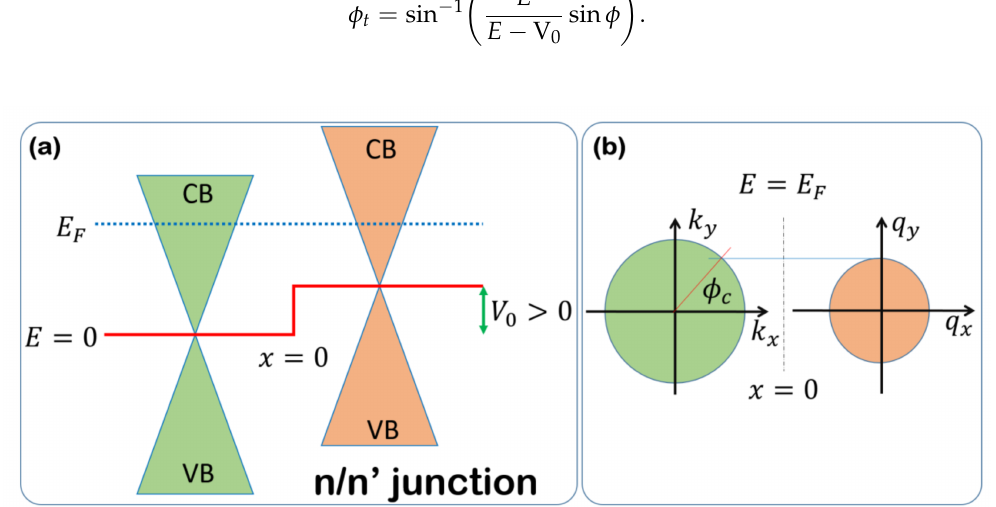
Figure 3. ( a ) Bands alignment of the n/n’ junction model considered in the main text. Grain boundary interface is located in x = 0. The system Fermi level is located above the Dirac points, and thus, a n-type conduction regime is established. ( b ) In the translational invariant system along the y-direction, the corresponding linear momentum is a conserved quantum number in the scattering events. When the incidence angle φ is greater than the critical angle φ c , the y-component of the linear momentum cannot be conserved, and no current can flow through the